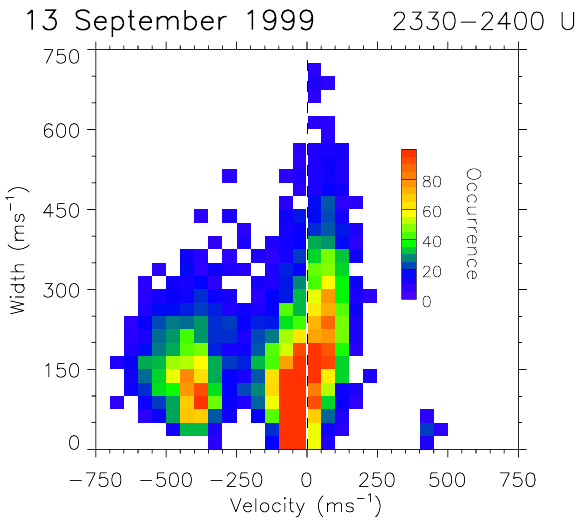
Fig. 7. Occurrence distribution of line-of-sight velocity against spectral width for all backscatter observed in features A and B be- tween 2330 and 2400